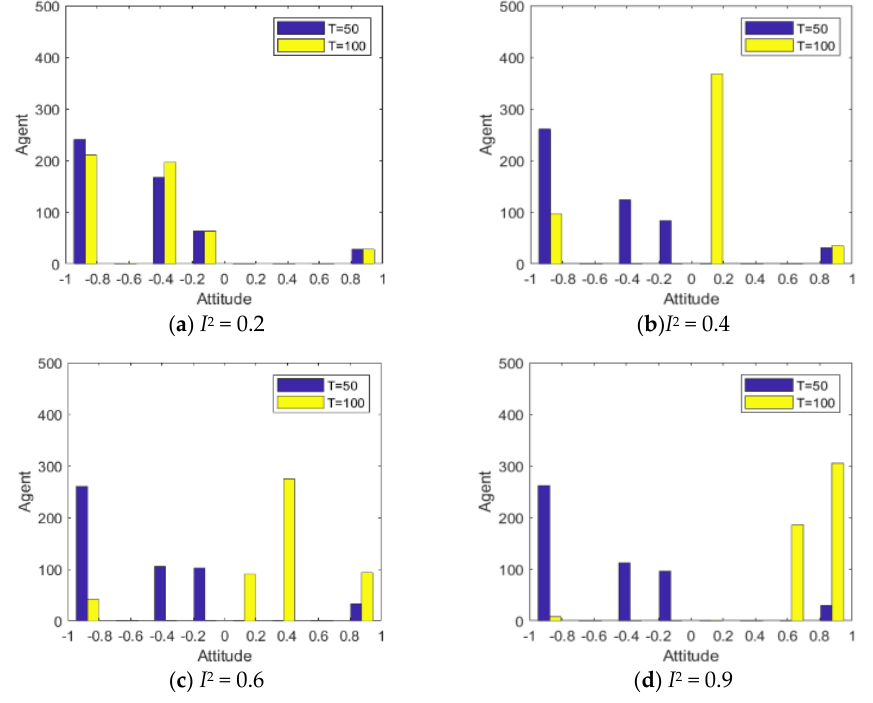
Figure 6. Group attitude distribution histogram. ( a ) I 2 = 0.2; ( b ) I 2 = 0.4; ( c ) I 2 = 0.6; ( d ) I 2 = 0.9.